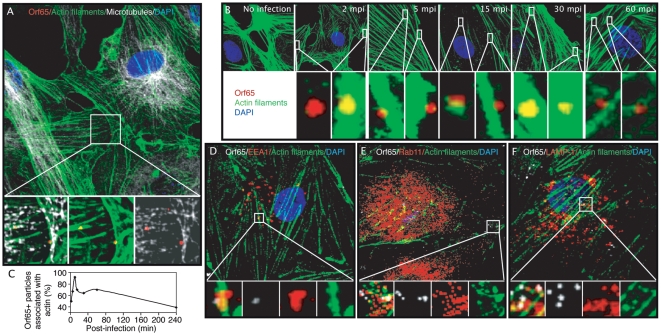
Association of Orf65+ KSHV capsids with actin filaments at different stages of endocytosis during KSHV entry and trafficking in endothelial cells.(A) HUVEC were infected with KSHV, fixed at 30 mpi, stained for Orf65+ viral capsids (red), actin filaments (green), and microtubules (white). The area highlighted by the square is enlarged and projected as 3D-projection images in the lower panels, which reveal the association of Orf65+ viral particles with actin filaments (middle), microtubules (right), and the merged image (left). (B) Time course analysis of the association Orf65+ viral particles with actin filaments. HUVEC were infected with KSHV, fixed at indicated time points post-infection, and stained for actin filaments (green), Orf65+ viral particles (red), and nuclei (blue). Highlighted sections in the upper panels were enlarged and shown as 3D-projection images in the bottom panels, which demonstrate the association of viral capsids with actin filaments at different time points of infection. (C) Quantification of the kinetics of colocalization of Orf65+ particles with actin filaments. (D–F) Association of Orf65+ viral particles shown in white with the endosomal protein EEA1 (D), Rab11 (E), or LAMP-1 (F), all in red, and actin filaments in green during KSHV entry of endothelial cells. HUVEC were prepared as described in (A) and labeled to visualize endosomal proteins, Orf65+ viral capsids and actin filaments. The sections highlighted by the squares are enlarged in the lower panels. For corresponding 3D projection of colocalization of Orf65+ particles with actin filaments and EEA1, Rab11 and LAMP-1, see Videos S13, S14 and S15.